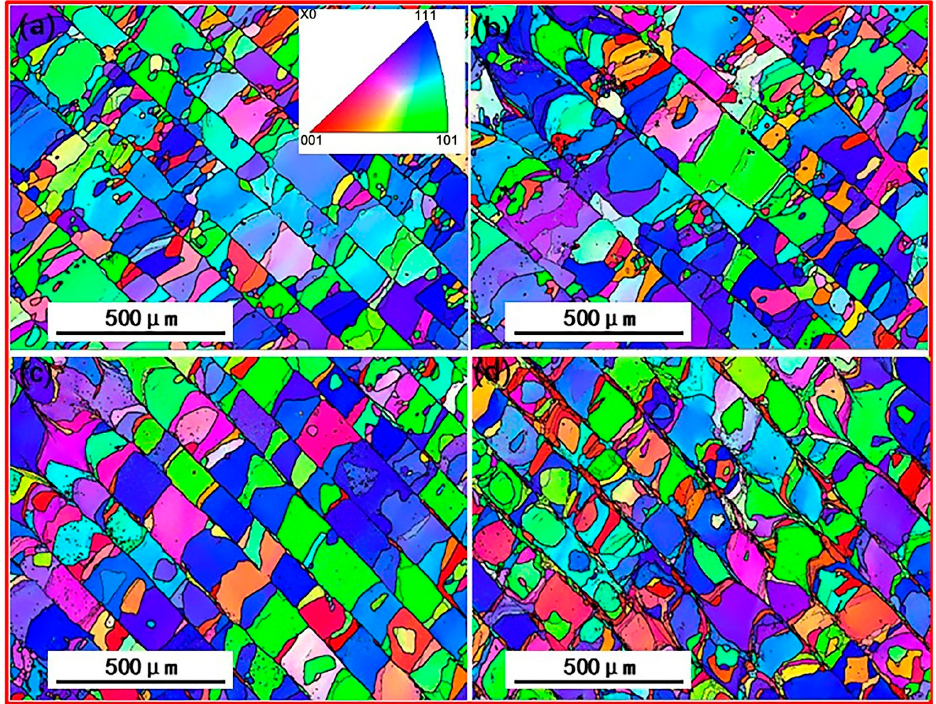
Figure 6. IPF maps of the XY plane for the Ti-22Al-25Nb alloy formed through SLM at four scanning speeds: ( a ) sample 1, ( b ) sample 2, ( c ) sample 3, and ( d ) sample 4.